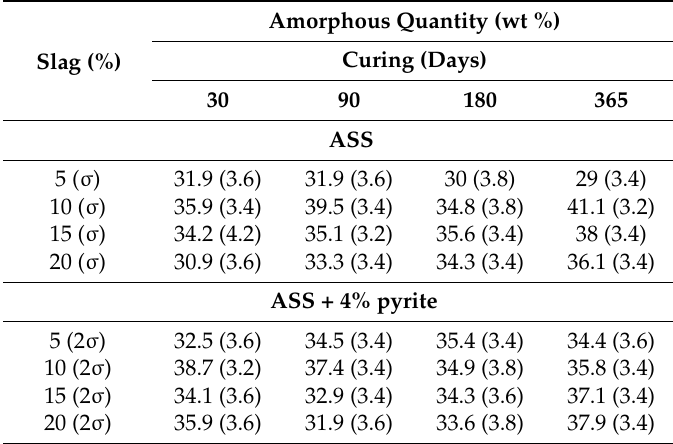
Table 5. Change of amorphous quantities (wt %) of treated ASS with curing and slag contents (standard deviations are in